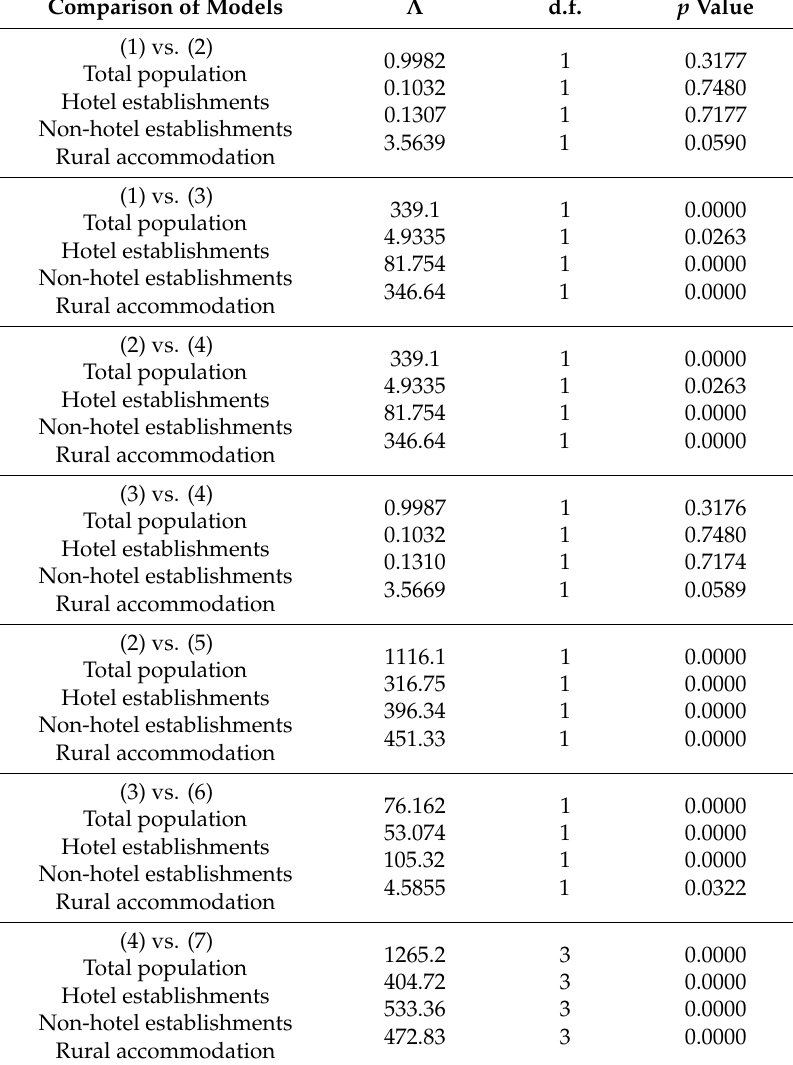
Table 9. Composite likelihood ratio tests (comparison between nested